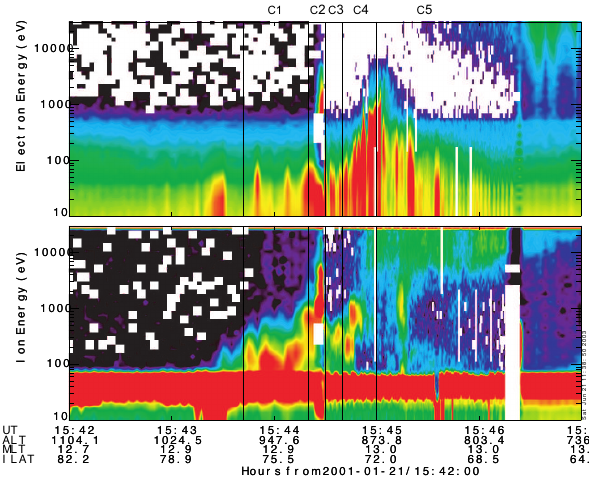
Fig. 9. Electron and ion spectrograms from FAST for the interval 15:42–15:47 UT, during which FAST descends 17.3 ◦ in ILAT, mov- ing approximately along the 13:00 MLT meridian. Vertical lines have been drawn to delimit the extent of the field-aligned currents described in Fig. 10.